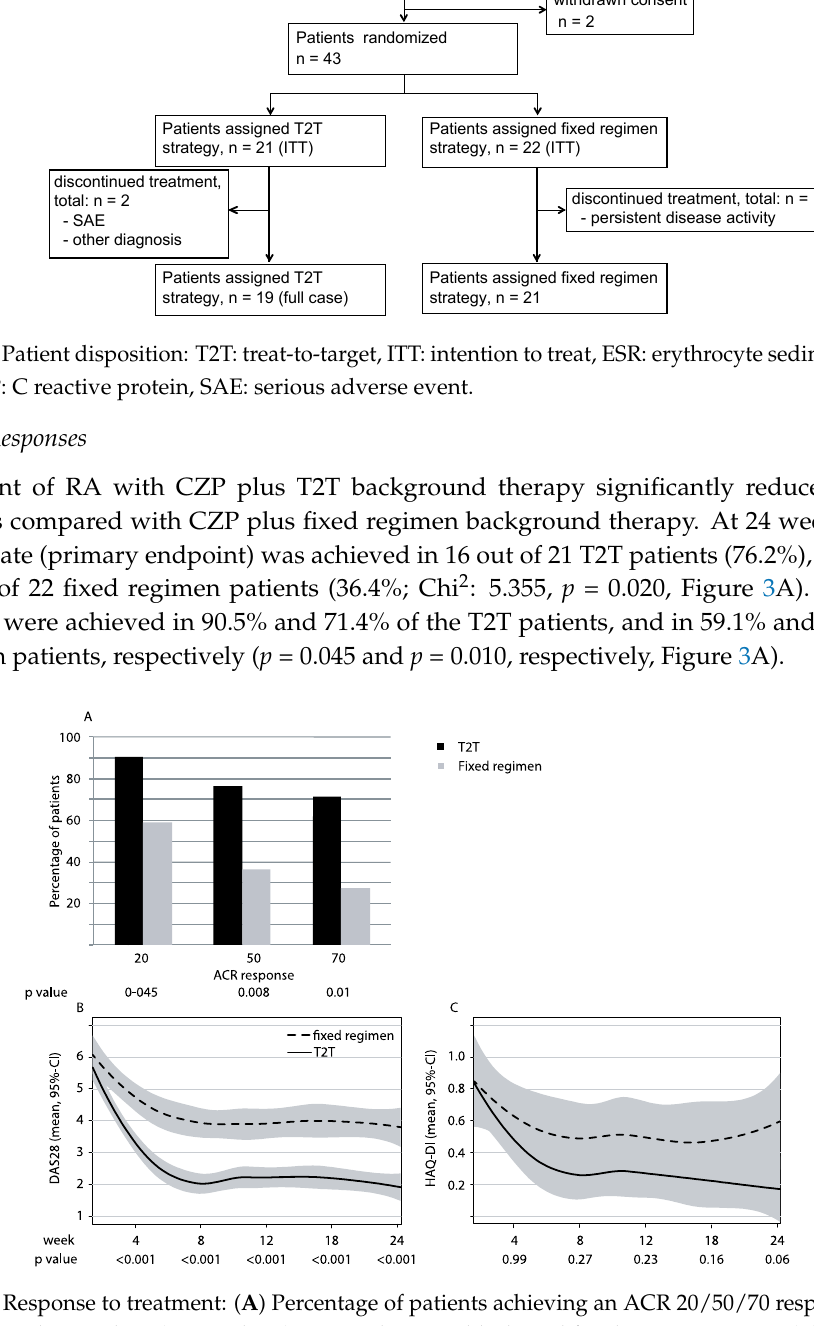
Figure 3. Response to treatment: ( A ) Percentage of patients achieving an ACR 20/50/70 response was demonstrated at week 24 (ITT analysis). T2T is shown in black, and fixed regimen in grey. ( B ) Average disease activity score in 28 joints (DAS 28) at baseline and during follow up until week 24. ( C ) Average health assessment questionnaire disability index (HAQ-DI) at baseline and during follow up until week 24. All data are shown for the two patient groups as means with the 95% confidence interval: T2T solid black line, and fixed regimen as a striped line; ACR: American college of rheumatology, ITT: intention to treat, T2T: treat to